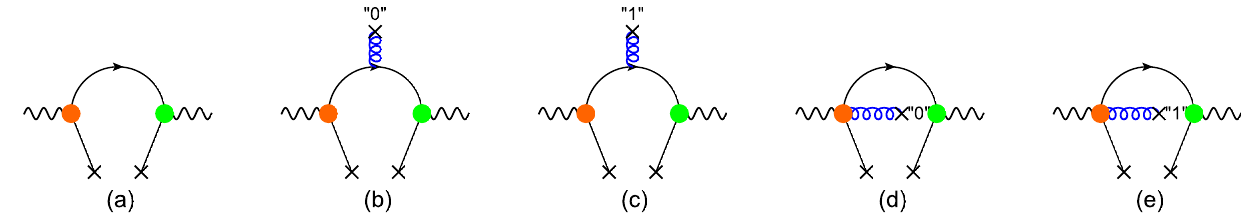
Fig. 2 Feynman diagrams for the second term of Eq. (18). The left big ground field, and “ n ” indicates n th -order covariant derivative, and the ↔ cross symbol attached to the quark line stands for the local light u or d dot and the right big dot stand for the vertex operators (cid:13) z γ 5 ( z · D ) n and quark background (cid:13) z γ ( x ) and J † ( 0 ) , respectively. The cross symbol 5 in the currents J n 0 attached to the gluon line indicates the tensor of the local gluon back-